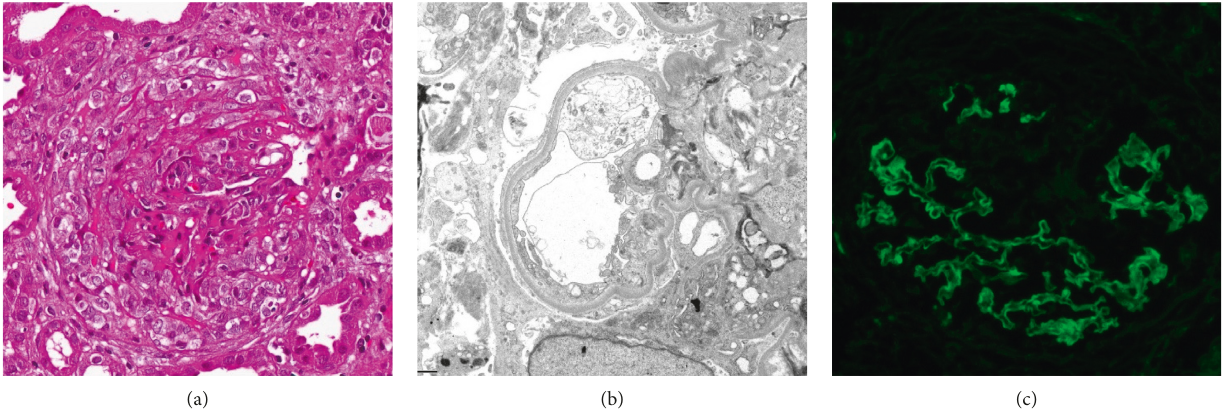
Figure 1: (a) Light microscopy reveals glomeruli with cellular to focally fibrocellular crescent formation and underlying segmental tuft fibrinoid necrosis. Red blood cell casts are noted. There is severe mononuclear inflammation within the interstitium (H&E, 10x). (b) Electron microscopy demonstrates peripheral capillary loops of normal thickness and architecture with widespread effacement of the overlying foot processes. (c) Immunofluorescence microscopy shows strong linear staining along glomerular basement membranes with IgG (4+) and kappa and lambda light chains (3-4+).